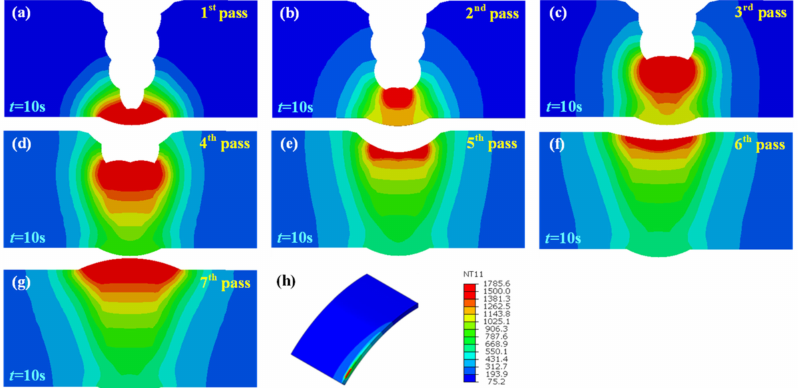
Figure 9. Joint temperature field with 2 mm butt gap: ( a – g ) temperature distribution of each pass, ( h ) isometric view of temperature